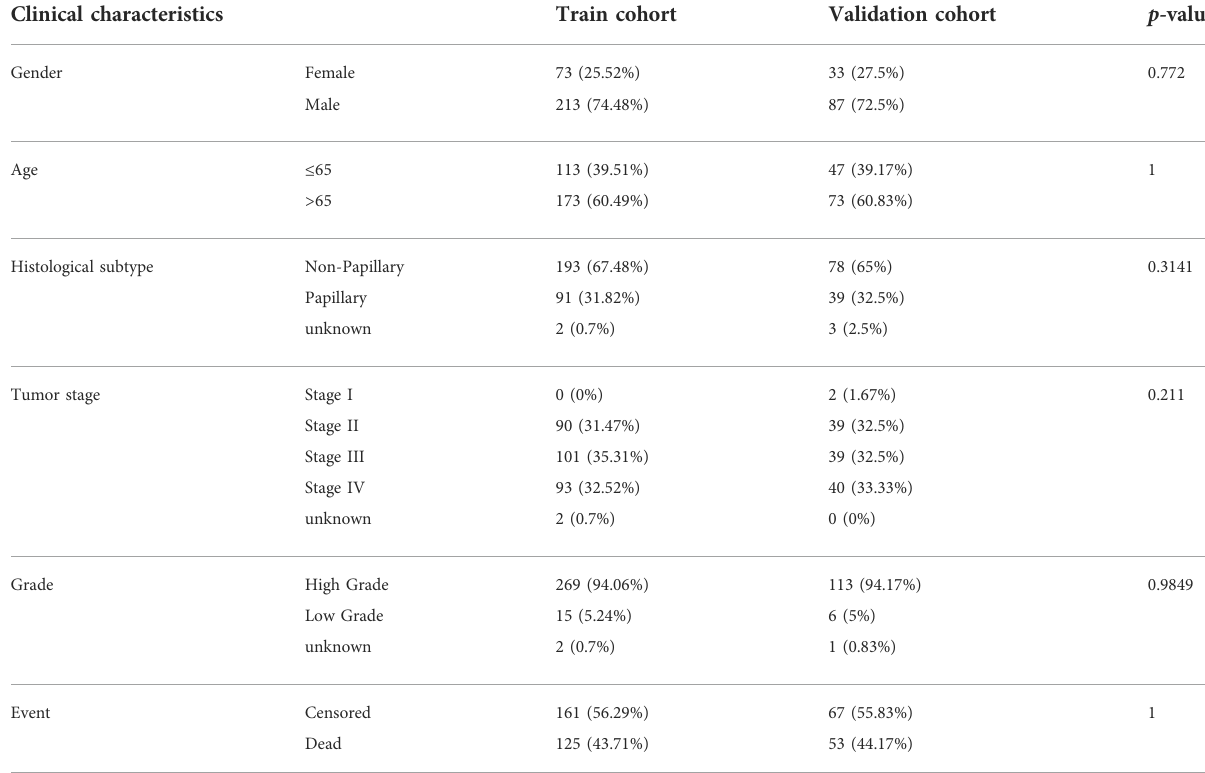
TABLE 1 The clinical characteristics of the train cohort and validation